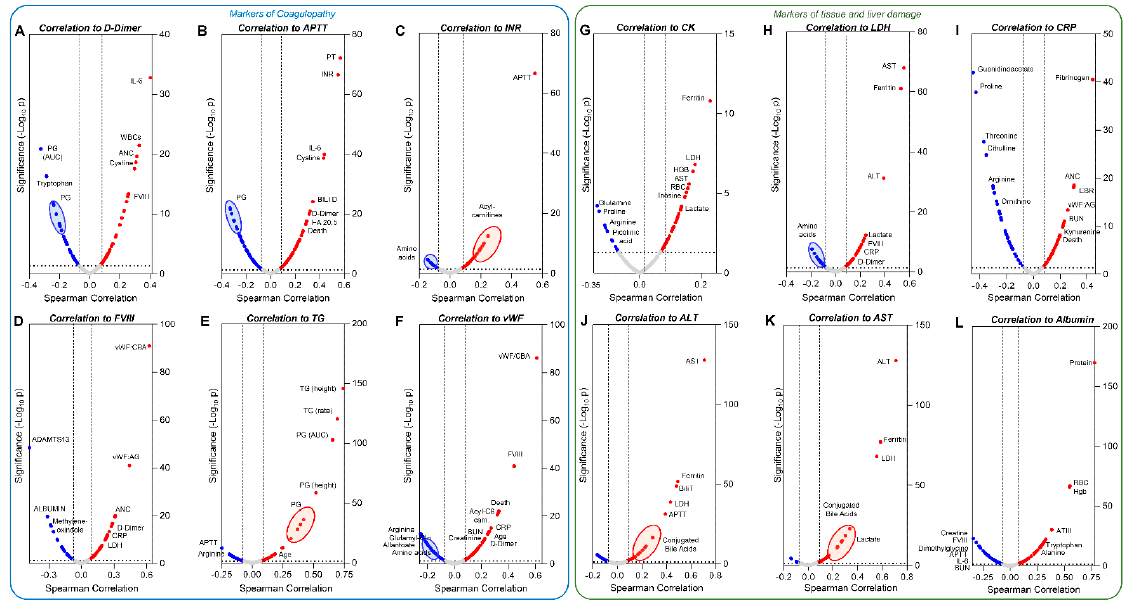
Figure 5. Metabolic correlates to coagulation parameters and markers of tissue and liver damage. Spearman correlation analyses correlated clinical and metabolic parameters to coagulation status ( A – F ) or tissue damage ( G – L ). Volcano plots represent metabolites that have significant ( p < 0.05) positive (red) or negative (blue) correlations with any of the parameters. Parameters are abbreviated using standard clinical terms.